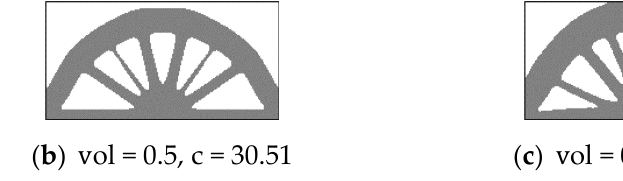
Figure 15. Optimization results of half-wheel beams with different volume fractions. The optimization results obtained using the SIMP and BESO methods are shown in Figure 16.